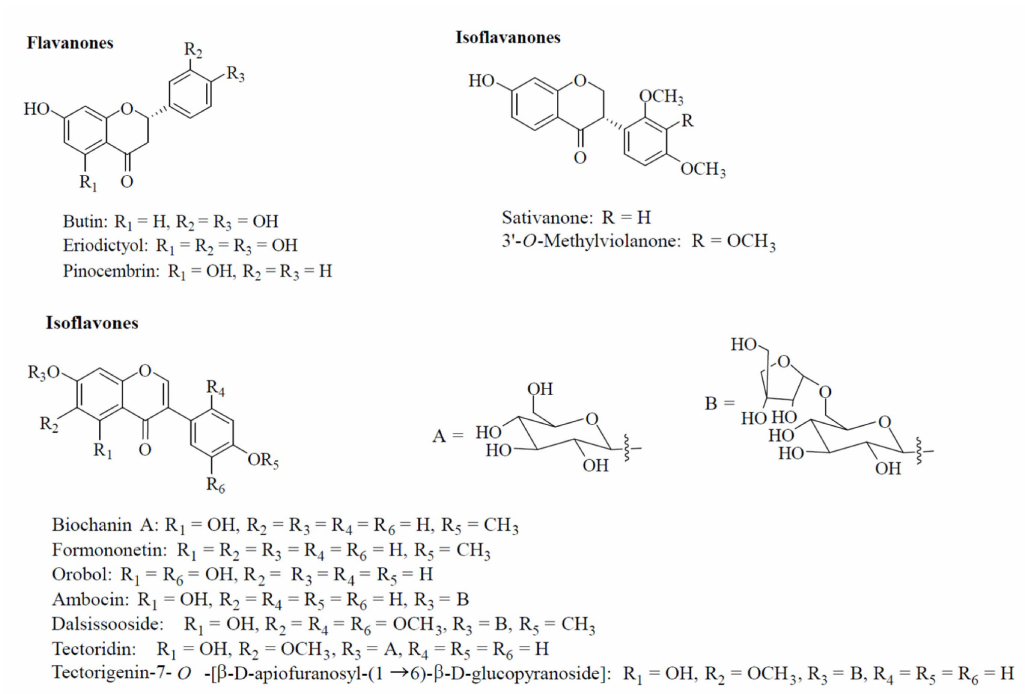
Figure 1. Structures of the molecules isolated from the heartwoods, roots, and leaves of Dalbergia tonk- inensis . Compounds are grouped according to the subclass of flavonoids to which they